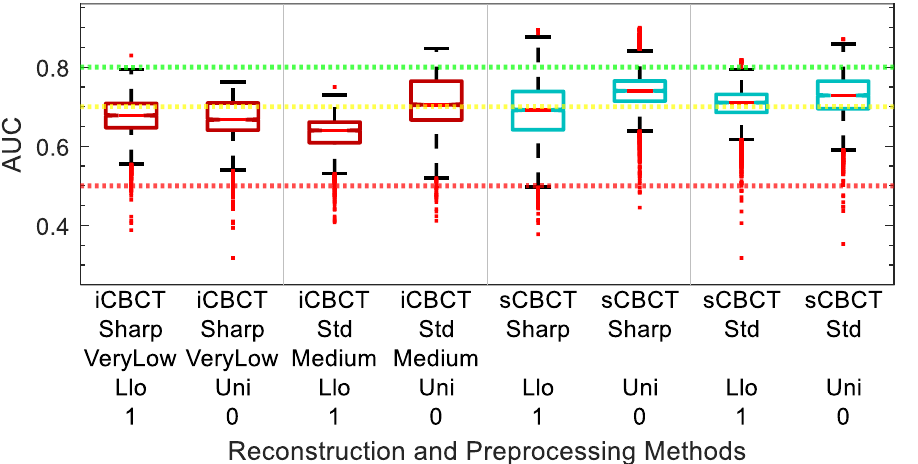
Figure 5. Acute GU Toxicity AUC of delta-radiomic models vs Reconstruction and Preprocessing methods. The AUC collected over 1000 iterations of the leave-one analysis and over all BED bins.